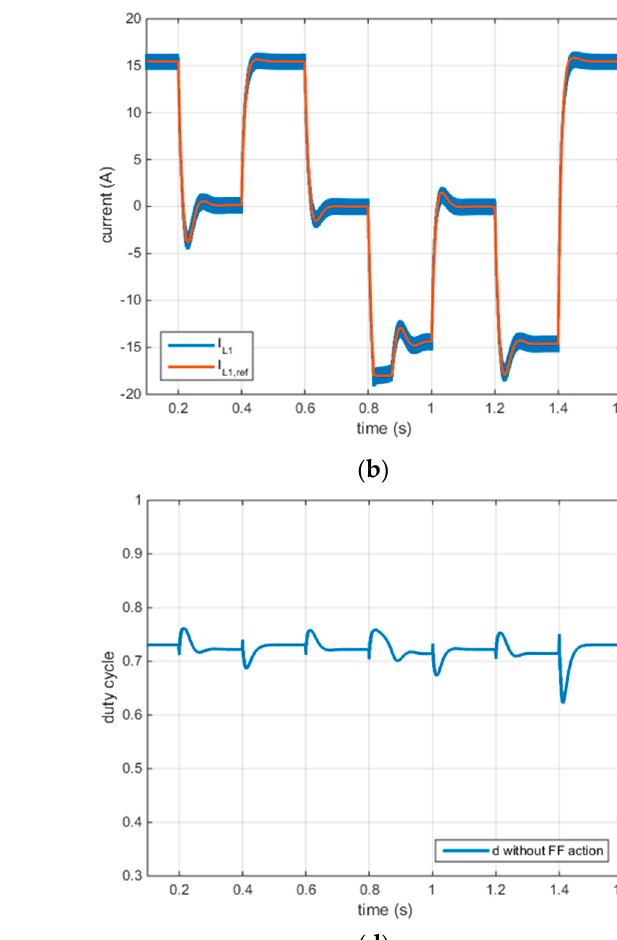
( d ) Figure 4. Performance obtained in scenario #1 (SS − GN): ( a ) output current and load current; ( b ) input inductor current; ( c ) external generator’s current; ( d ) duty cycle.